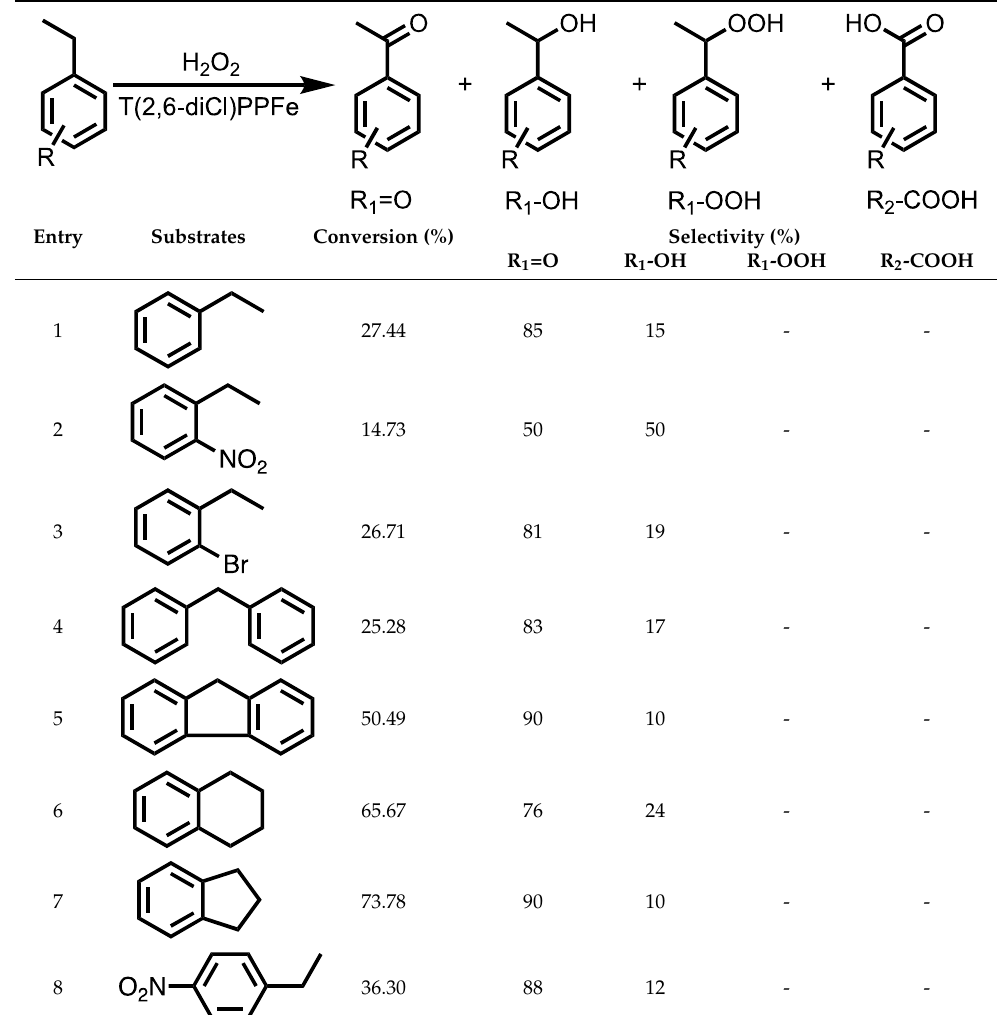
Table 7. Ethylbenzene and its derivates oxygenation employing H 2 O 2 catalyzed by T(2,6-diCl)PPFe a .